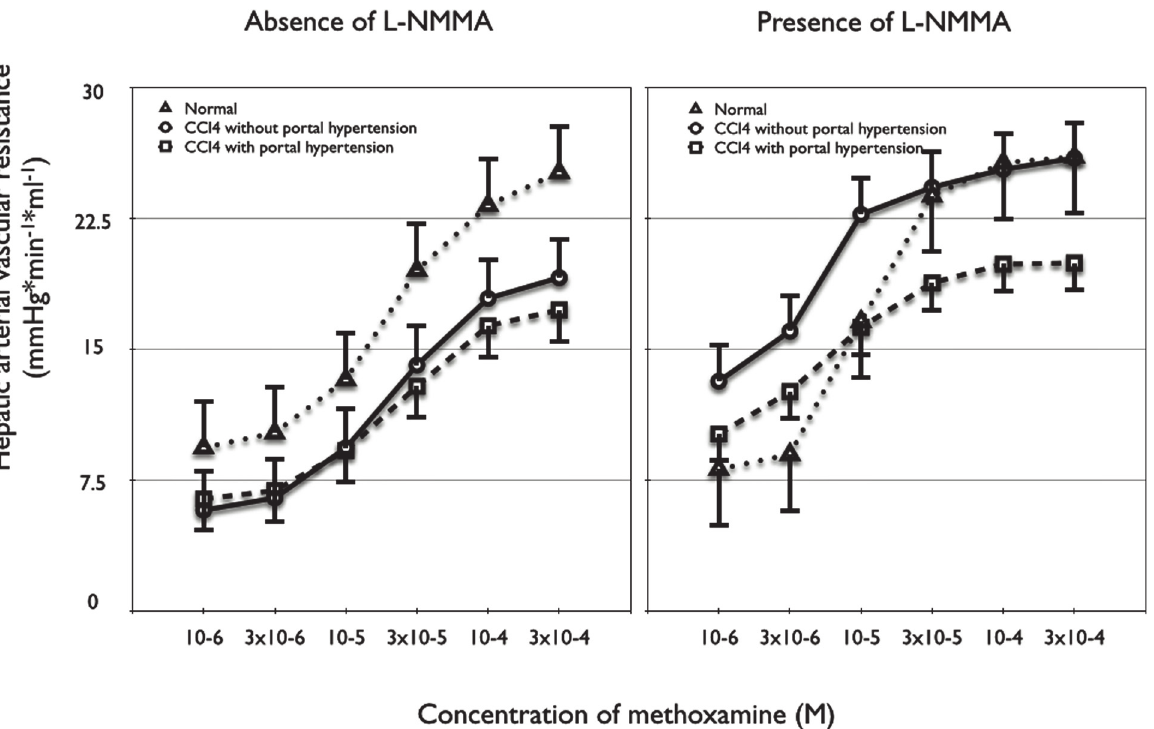
Fig 2. Dose-response curves to methoxamine in absence (left side) and presence (right side) of the nitric oxide synthetase inhibitor L-NMMA. Left side showing a higher hepatic arterial vascular resistance in normal (n = 10) compared to cirrhotic rats with normal portal resistance (n = 6; p = 0.046) and compared to cirrhotic rats with elevated portal resistance (n = 7; p = 0.018). Right side showing no significant differences between hepatic arterial vascular resistance in normal (n = 10) and cirrhotic rats with normal portal resistance (n = 6; 0.321) as well as with elevated portal resistance (n = 7; p = 0.835). Note the difference in maximal vasoconstriction between rats with or without elevated portal resistance/normal as a sign of less smooth muscles in cirrhosis with elevated portal